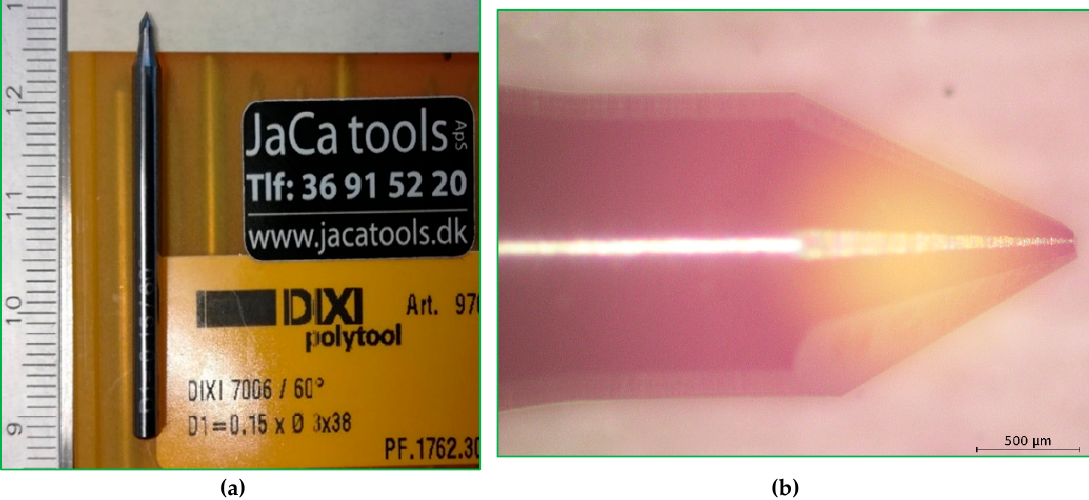
Figure 2. ( a ) Digital picture of the milling tool, DIXI 7006. ( b ) Microscopic picture of the tip of the milling tool (engraving tool ¾).